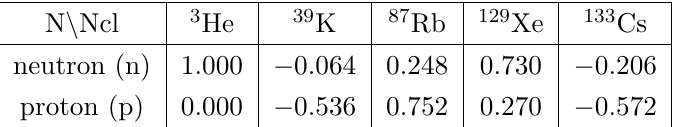
for the di(cid:11)erent nucleons and nuclei of interest. Ncl